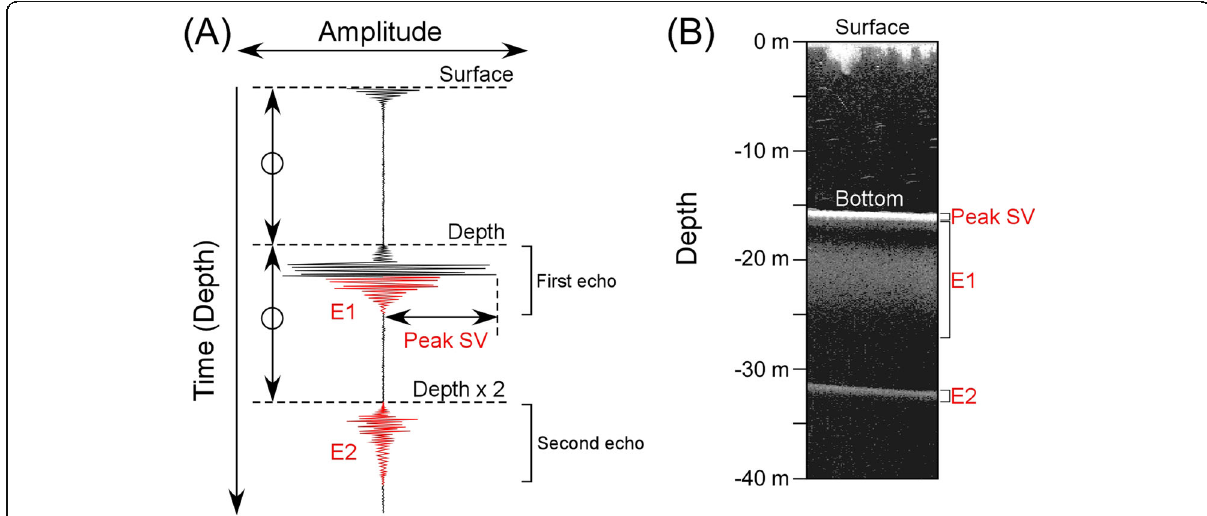
Fig. 4 Visualization of E1, E2, and peak SV. a Conceptualized E1, E2, and peak SV indices for a single acoustic reflection (modified from Penrose et al. 2005). The first echo appears at the bottom depth, and the second echo appears at double that depth. Peak SV is an index for the strongest reflections in the first echo. b The E1 and E2 layers and the position of peak SV in a part of a 200 kHz acoustic profile (based on the ReefMaster reference manual, ReefMaster Software